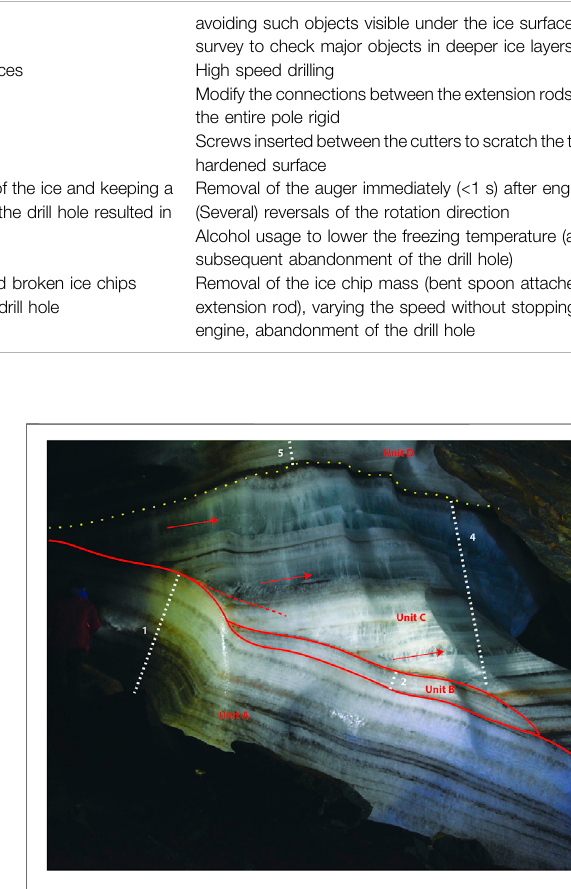
FIGURE 3 | The lower section of the ice block in Svarthammarhola, Cave, Norway. The red arrows indicate layers of clear ice, formed as ponds of water frozen from top to bottom. The red dashed line indicates the (potential) former topofUnitA.Thestippledyellow lineindicatesamassive fl ooding episode. The white dashed lines (1 – 5) indicate the longest potential paleoclimate record. The caver on the left is ∼ 1.80 m